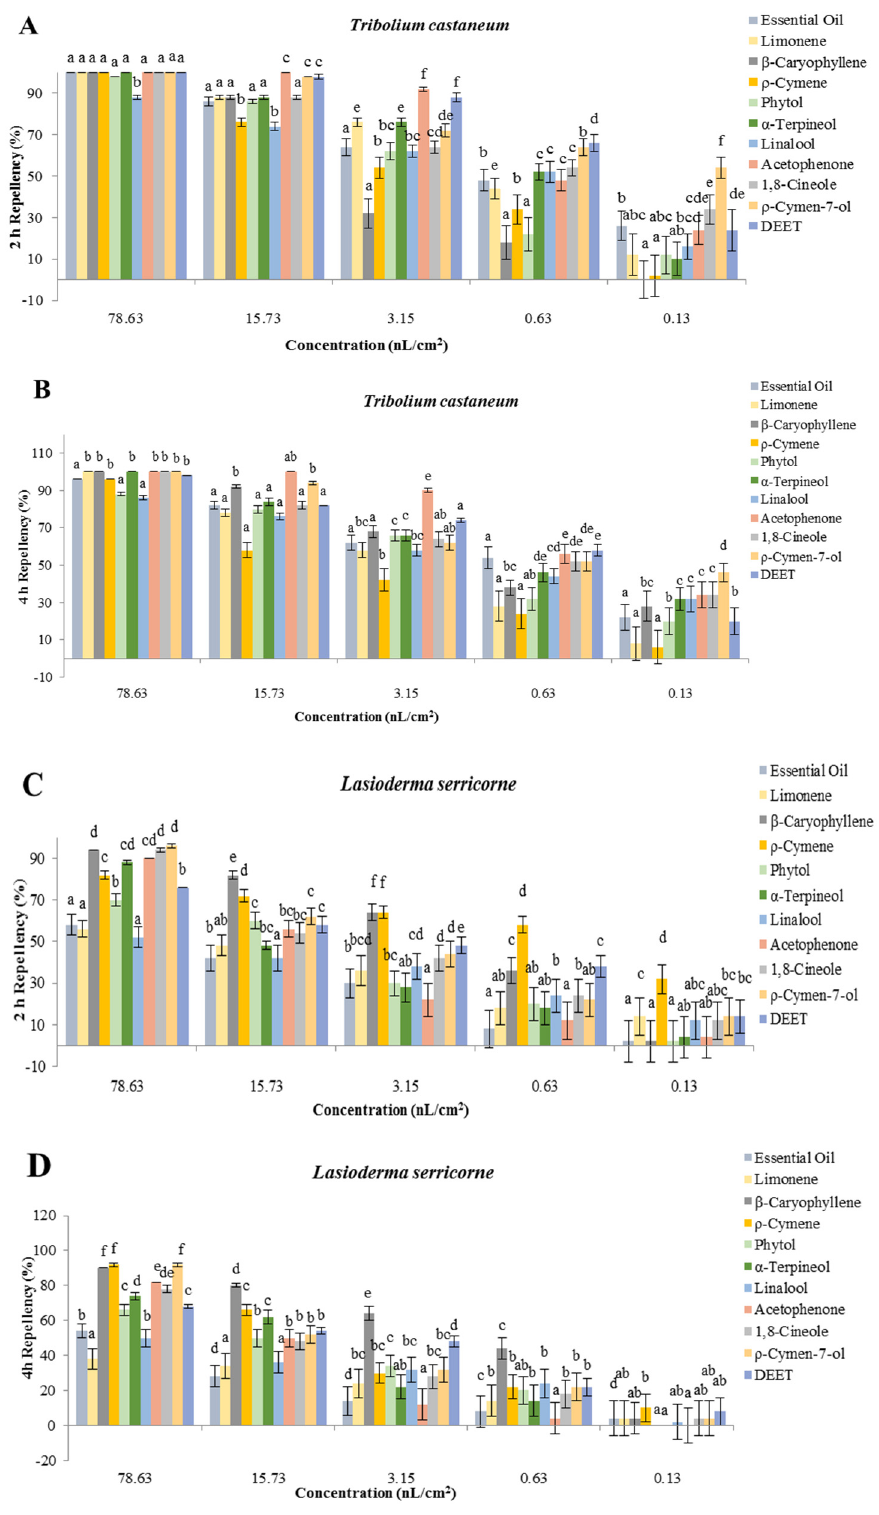
Figure 2. Percentage repellency (PR) of EO and compounds extracted from the E. densa against T. castaneum and L. serricorne at 2 h ( A , C ) and 4 h ( B , D ) after exposure. Differences between PR values of EO and DEET at the same concentration were determined by t -test ( p < 0.05). At the same concentration, means (± standard deviation) noted by the same lowercase letter do not differ significantly.